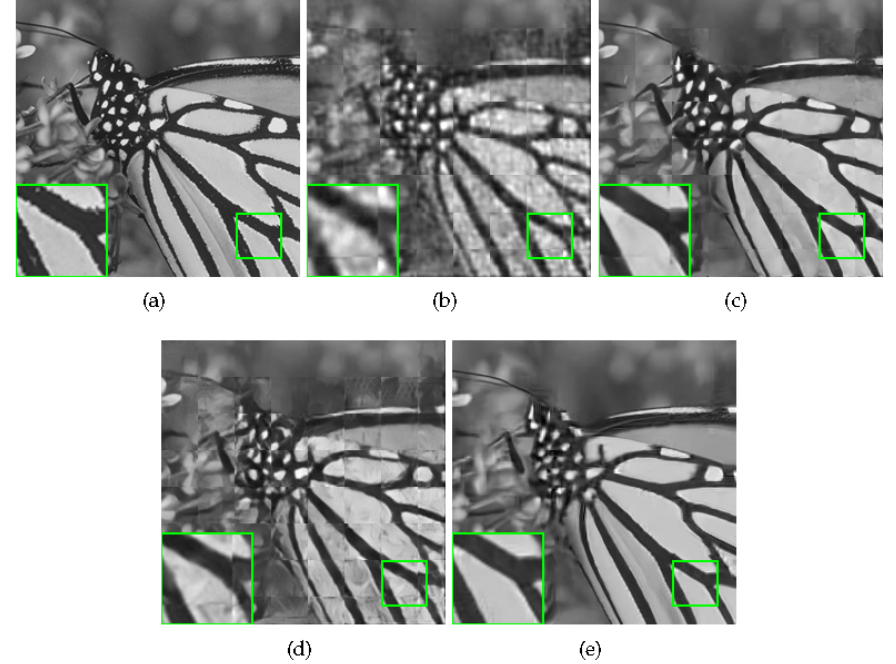
Figure 9. Reconstruction of Monarch with sampling rate = 0.1. ( a ) Original image; ( b ) ReconNet (PSNR = 21.11 dB, FSIM = 0.7406); ( c ) ISTA-Net + (PSNR = 26.58 dB , FSIM = 0.8816); ( d ) DR 2 -Net (PSNR = 23.10 dB, FSIM = 0.8184); ( e ) Proposed HNLSR (PSNR = 26.26 dB, FSIM = 0.8907